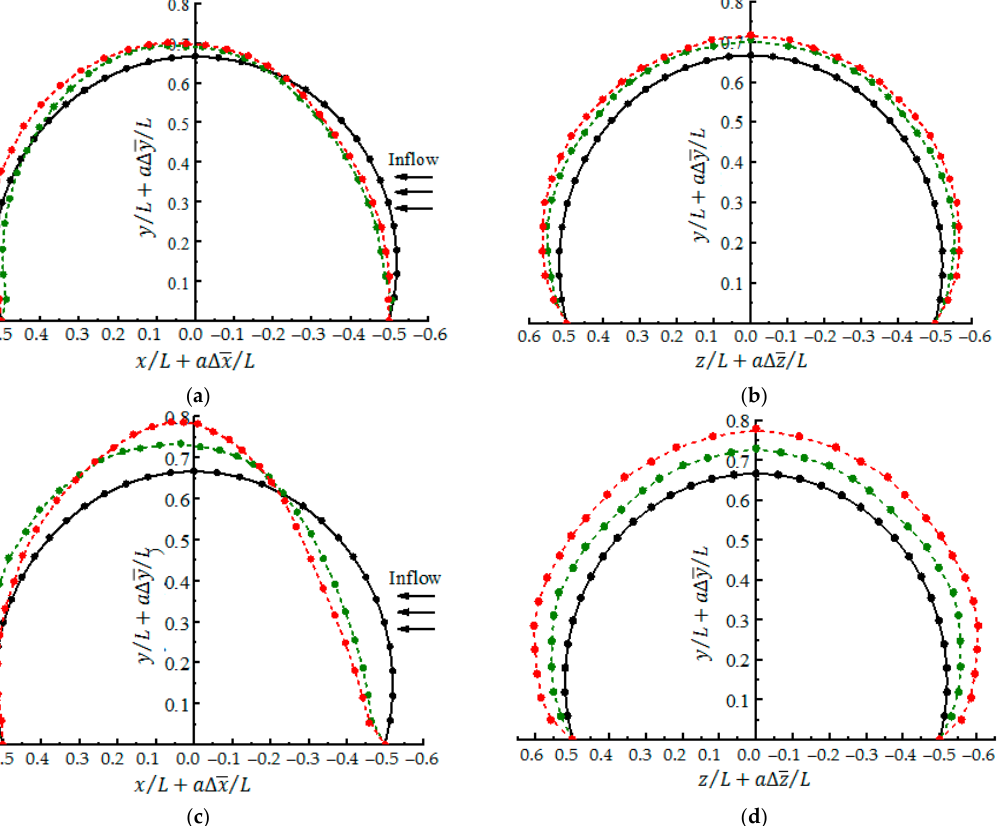
Figure 14. Transient deformation profile of the model: ( a ) in along-wind direction at u = 4 m/s, ( b ) in cross-wind direction at u = 4 m/s, ( c ) in along-wind direction at u = 11 m/s, and ( d ) in cross-wind direction at u = 11 m/s. The black line indicates the initial shape of the model, the green line indicates the minimum transient deformation position, and the red line indicates the maximum transient deformation position in the figure.